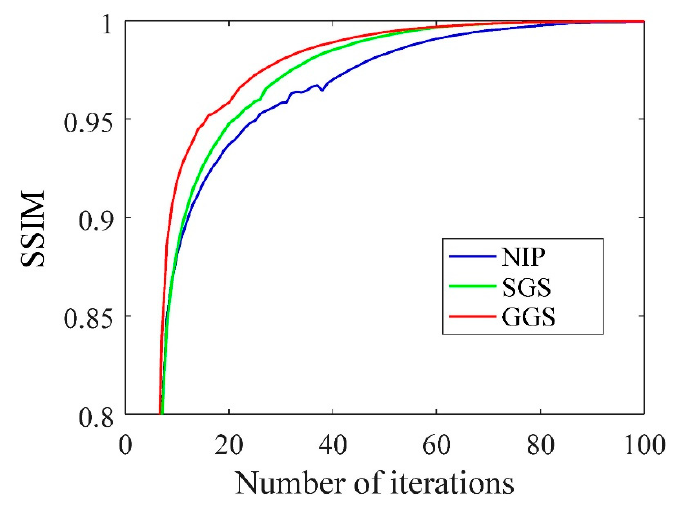
Figure 12. The iteration convergence curve of the vortex phase using three modified GS